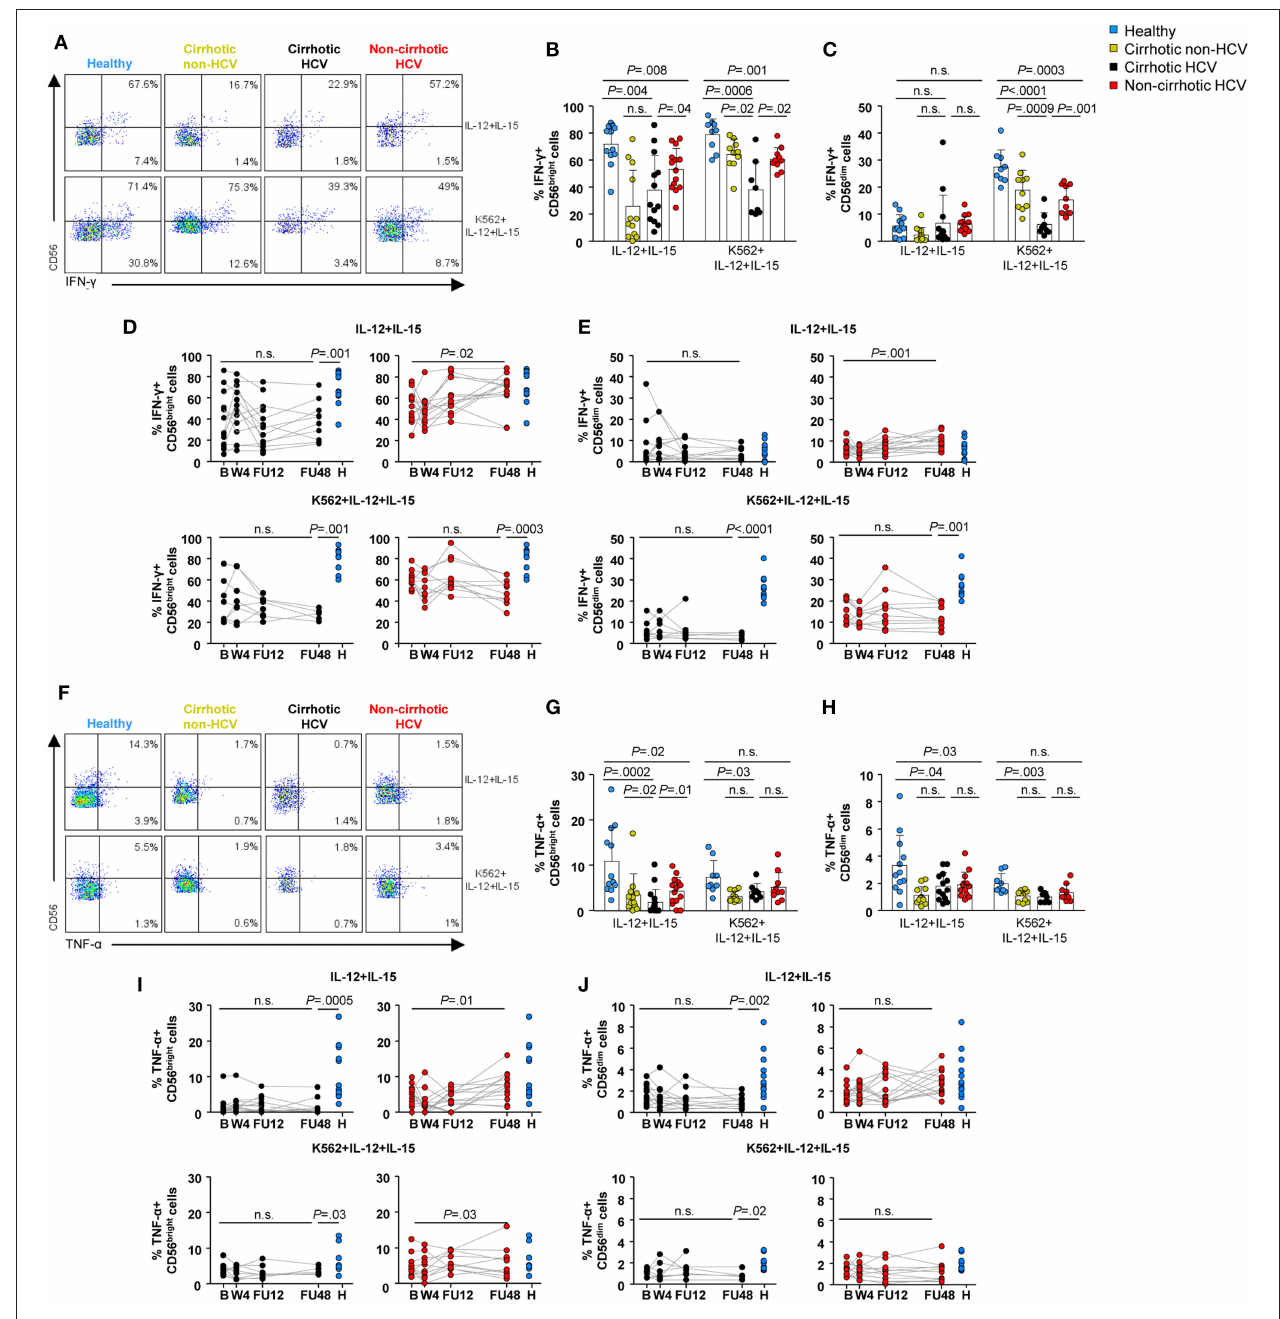
FIGURE 6 | NK cell cytokine production was not restored in HCV patients with cirrhosis 1 year after the end-of-therapy. Representative flow cytometry plots (A) and baseline frequencies of IFN- γ + CD56 bright (B) and CD56 dim (C) cells after IL-12 and IL-15 or IL-12, IL-15, and K562 stimulation. Longitudinal analysis of IFN- γ -producing CD56 bright (D) and CD56 dim (E) cells in cirrhotic and non-cirrhotic HCV patients. Representative flow cytometry plots (F) and baseline frequencies of TNF- α + CD56 bright (G) and CD56 dim (H) cells after IL-12 and IL-15 or IL-12, IL-15, and K562 stimulation. Longitudinal analysis of TNF- α -producing CD56 bright (I) and CD56 dim (J) cells in cirrhotic and non-cirrhotic HCV patients. P- values were determined during the longitudinal analysis by using mixed models for repeated measurements, and P -values between healthy controls and the different time point were determined by Mann–Whitney U test; n.s., not significant.